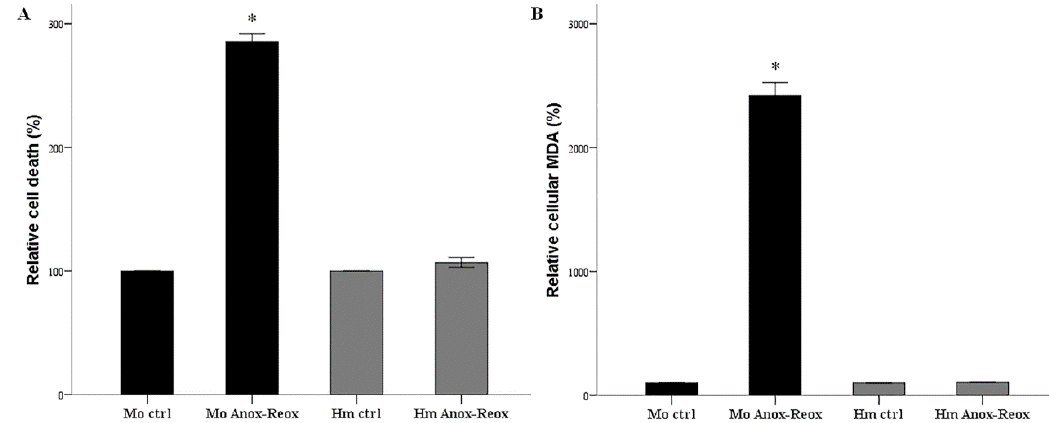
Figure 1. Cell death and lipid peroxidation due to warm anoxia-reoxygenation. LDH release assay revealed that warm anoxia-reoxygenation induced cell death in mouse RPTECs, whereas hamster RPTECs tolerated 24 h of anoxia followed by 2 h of reoxygenation. These experiments were repeated nine times in triplicate ( A ). Measurement of cellular MDA revealed that in mouse RPTECs, warm anoxia-reoxygenation caused robust lipid peroxidation. On the contrary, no lipid peroxidation was detected in hamster RPTECs. These experiments were performed nine times ( B ). Error bars correspond to SEM and the asterisk (*) to a p < 0.001 when compared to the respective control cells. Mo stands for mouse, Hm for hamster, ctrl for control, and Anox-Reox for anoxia-